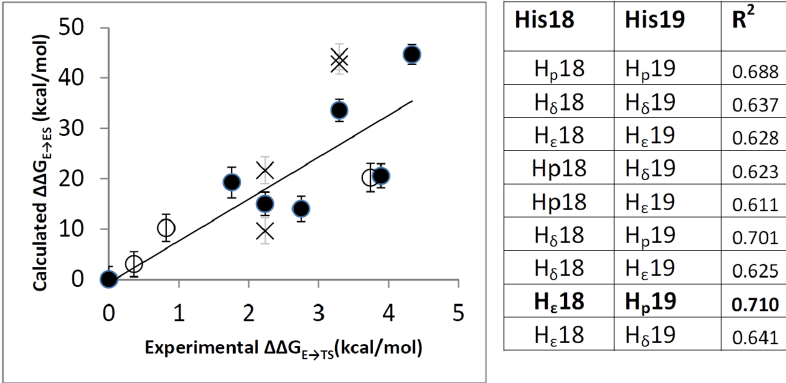
Figure 6. Relationship between experimental DD G E R TS and calculated DD G E R ES values using MM-GBSA. (left) Plot of the relationship: mutants included in the best correlation are represented with close circles, mutants that include a histidine that was not selected in the best correlation are represented with a cross, peptides with smaller chain are represented with open circles. (right) Different R 2 values when different pairs of histidine mutants are included in the correlation, the best correlation is in bold letter.